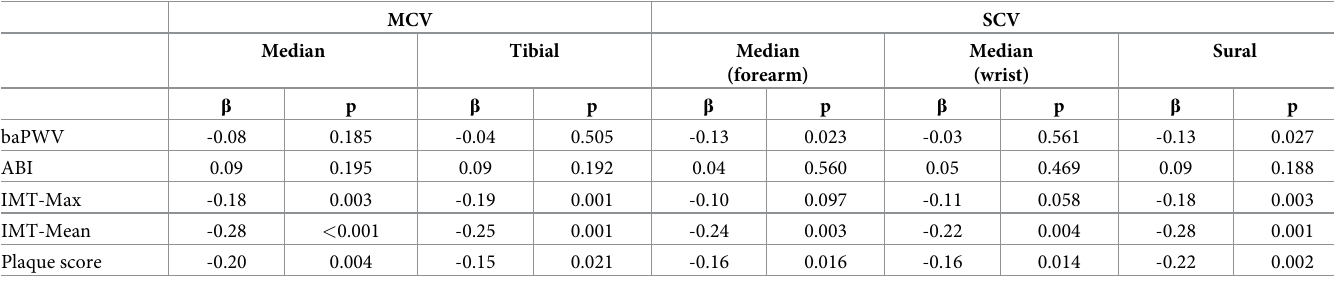
Table 3. Association between NCV and atherosclerosis